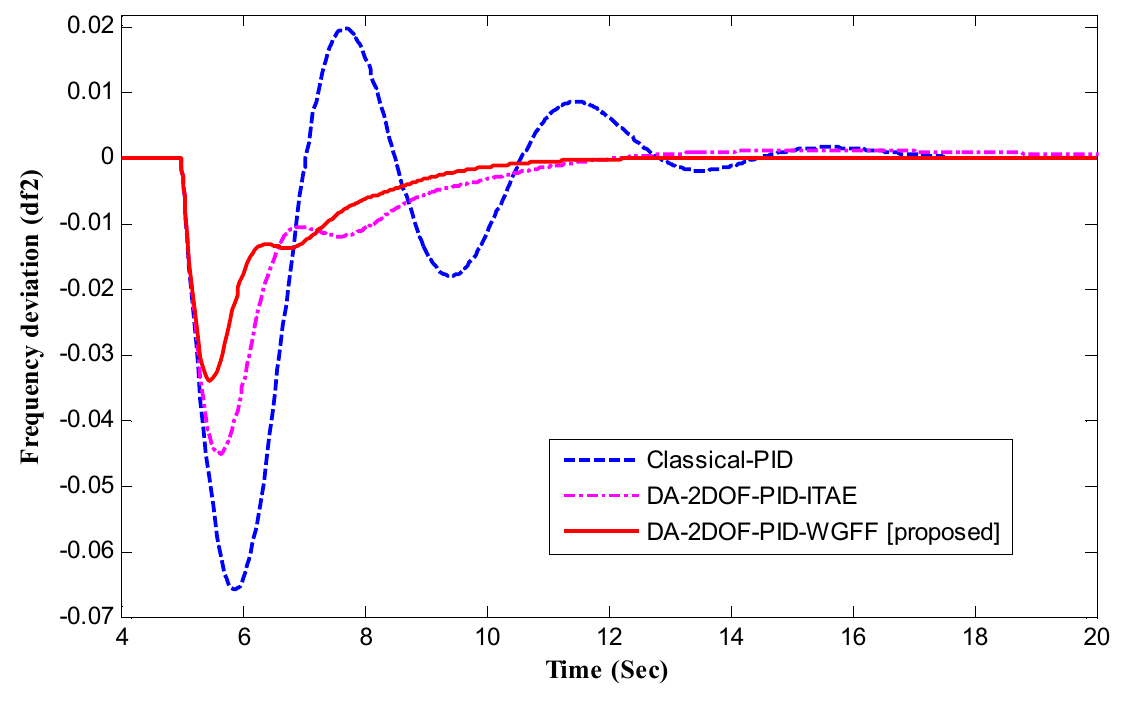
Figure 15. 𝜟𝒇 𝟏 using the proposed 2DOF-PID controller compared with other controllers.